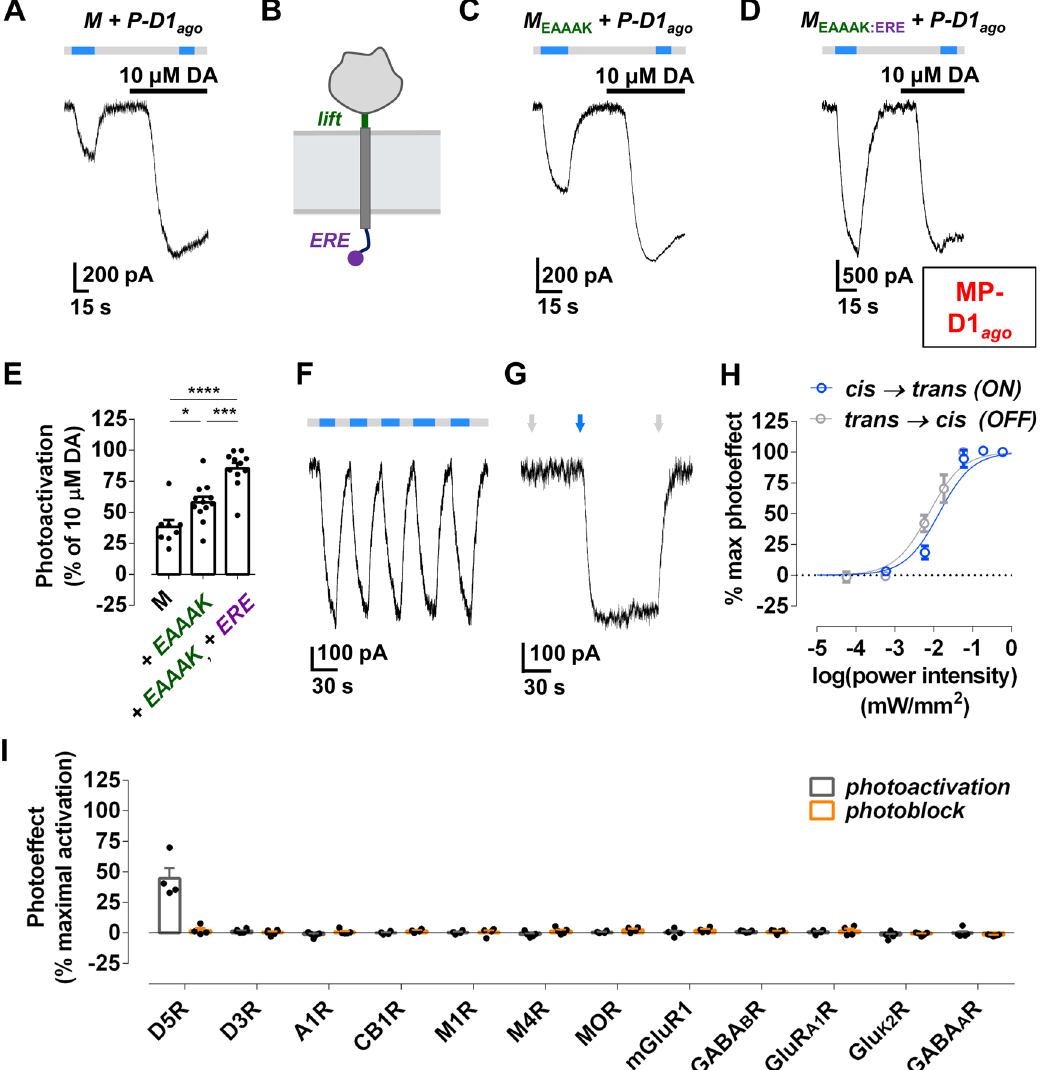
Fig. 2 MP-D1 ago photoactivates D1R. ( A ) Photoactivation of D1R by P-D1 ago tethered to the M, according to a receptor mediated-GIRK activation assay in HEK293T cells. The receptor is partially photoactivated with blue light (460 nm) and is deactivated with UV light (370 nm) relative to a saturating concentration of DA. ( B - D ) The incorporation of the rigid lift peptide EAAAK (dark green) and an endoplasmic reticulum export motif (ERE; purple) in the M enhances photoactivation of D1R. P-D1 ago attached to M EAAAK:ERE is MP-D1 ago . ( E ) Summary of photoactivation of D1R with variants of the MP with different Ms. one-way ANOVA, F = 22.5, Tukey, *p < 0.05, ***p < 0.001, ****p < 0.0001. n = 8 cells for M, n = 12 cells for M plus lift, and n = 11 for M plus lift and ERE. ( F ) Photoactivation of D1R with MP-D1 ago is rapid, reversible, and repeatable. ( G ) Photoactivation of D1R with MP-D1 ago is bistable. Arrows indicate a one second fl ash of UV or blue light. ( H ) Photoactivation and deactivation of D1R with MP-D1 ago as a function of light intensity. n = 5 cells per condition. ( I ) Summary of photoactivation (black) or photoblock of agonist-activation (red) by MP-D1 ago of selected receptors coexpressed in HEK293T cells. MP-D1 ago photoactivation of D5R is signi fi cantly greater than that of all other receptors tested. one-way ANOVA, F = 27.5, Tukey, p < 0.0001. n = 4 cells for D5R, CB1R, M1R, MOR, and GluR A1 R. n = 5 cells for A1R, M4R, GABA B R, Glu K2 R, and GABA A R. n = 6 cells for D3R. See Supplementary Fig. 12 for experimental details. Error bars indicate